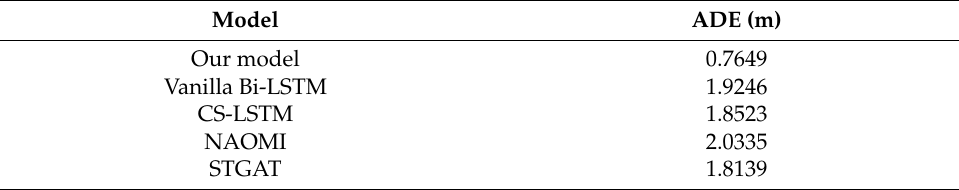
Table 3. Imputation errors in the Argoverse bidirectional trajectory completion